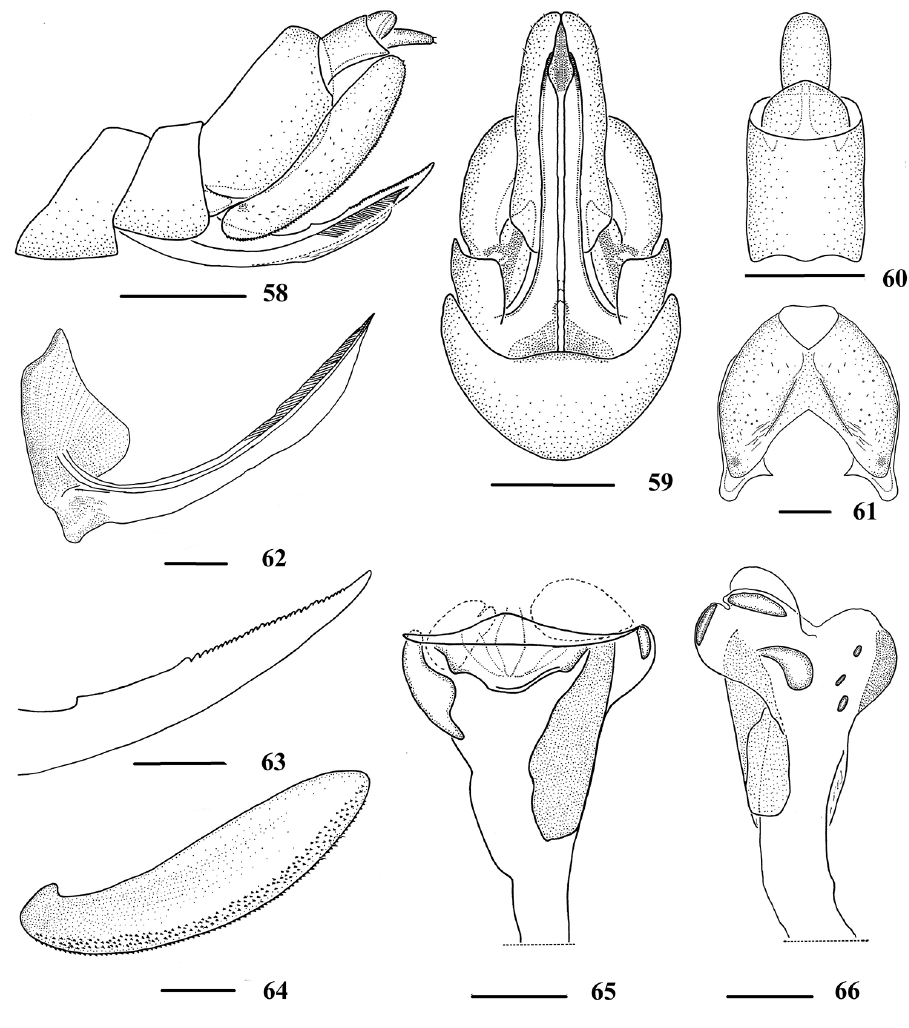
Figures 58–66. Neocarpia reversa sp. n., female 58 Genitalia, lateral view 59 Genitalia, ventral view 60 Anal segment, dorsal view 61 Pygofer, caudal view 62 Gonapophysis VIII and gonocoxa VIII, dorsal view 63 Gonapophysis IX, lateral view 64 Gonoplac, inner lateral view 65 Posterior vagina, ventral view 66 Posterior vagina, dorsal view. Scale bars: 0.5 mm ( 58–59 ); 0.2 mm ( 60–66 ). Remarks. Male genitalia of N. reversa sp. n. is similar to N. maai Tsaur & Hsu, 2003, but differs in: (1) left side of periandrium with a short reversed process basally ( N. maai without process in same position); (2) two processes on both lateral sides of periandrium near apex (three processes on periandrium near apex, two on ventral margin and one on right side in N. maai ); (3) flagellum with smooth apical margin (sinuate in N. maai